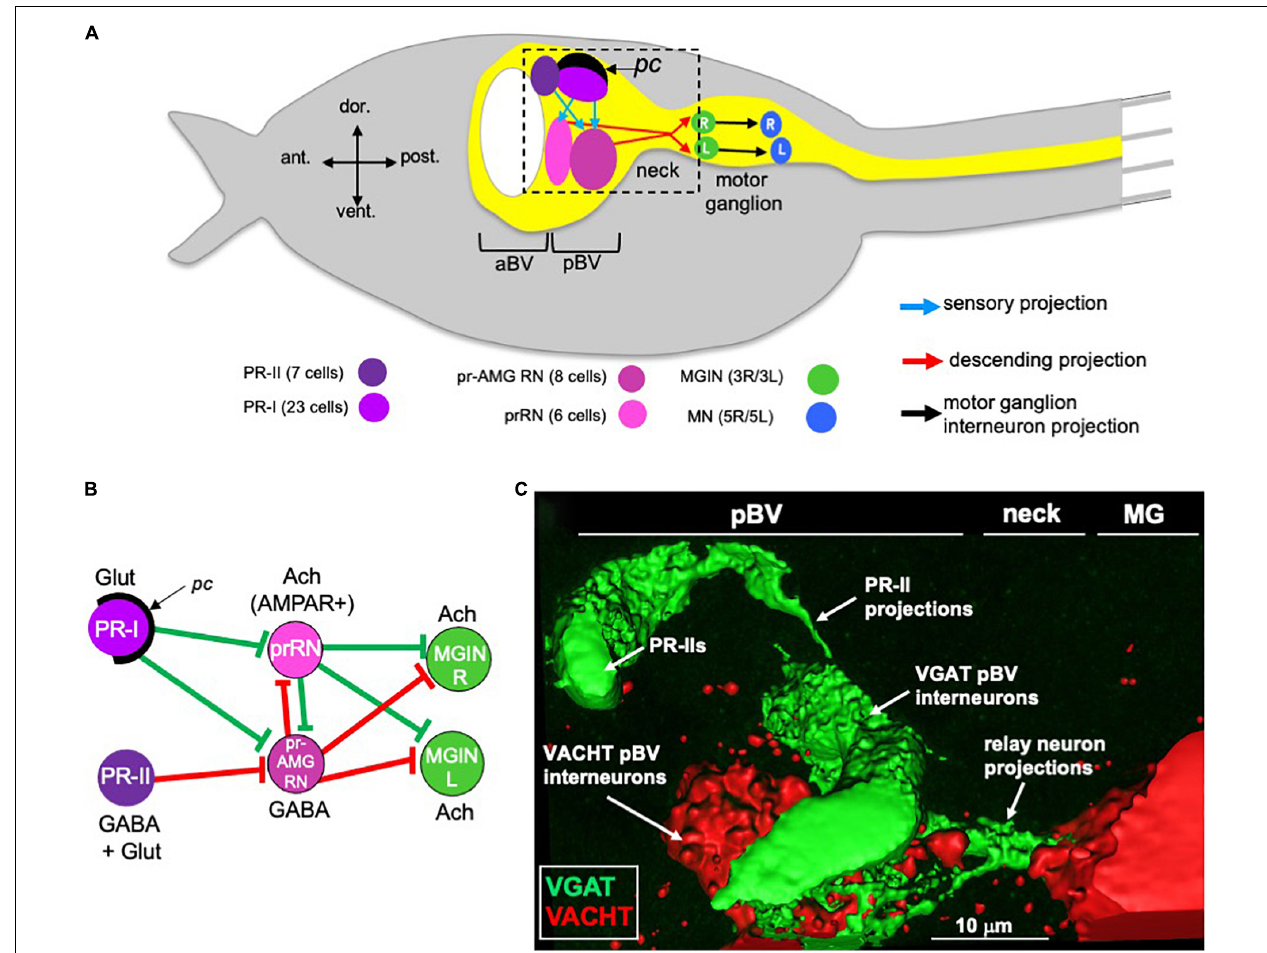
FIGURE 1 | Minimal visual circuitry and anatomy. (A) Cartoon of a Ciona larva, with emphasis on the anterior (only a small portion of tail is shown at right). Highlighted in the CNS (yellow) are the minimal visuomotor pathways. Cell classes are color coded according to Ryan and Meinertzhagen (2019), and the number of cells in each class are indicated in parentheses. (B) Minimal visuomotor circuits. Green lines indicate putative excitatory and red lines putative inhibitory synapses. (C) GABAergic PR-II photoreceptors project to GABAergic relay neurons in the pBV. View corresponds approximately to the dashed box in panel (A) . pc, pigment cell; aBV, anterior brain vesicle; pBV, posterior brain vesicle; PR, photoreceptor; pr-AMG RN, photoreceptor ascending motor ganglion relay neurons; prRN, photoreceptor relay neurons; MGIN, motor ganglion interneurons; MN, motor neurons; L, left; R, right; Glut, glutamate; Ach, acetylcholine; AMPAR, AMPA receptor; MG, motor ganglion; VGAT, Vesicular GABA transporter; VACHT, Vesicular acetylcholine